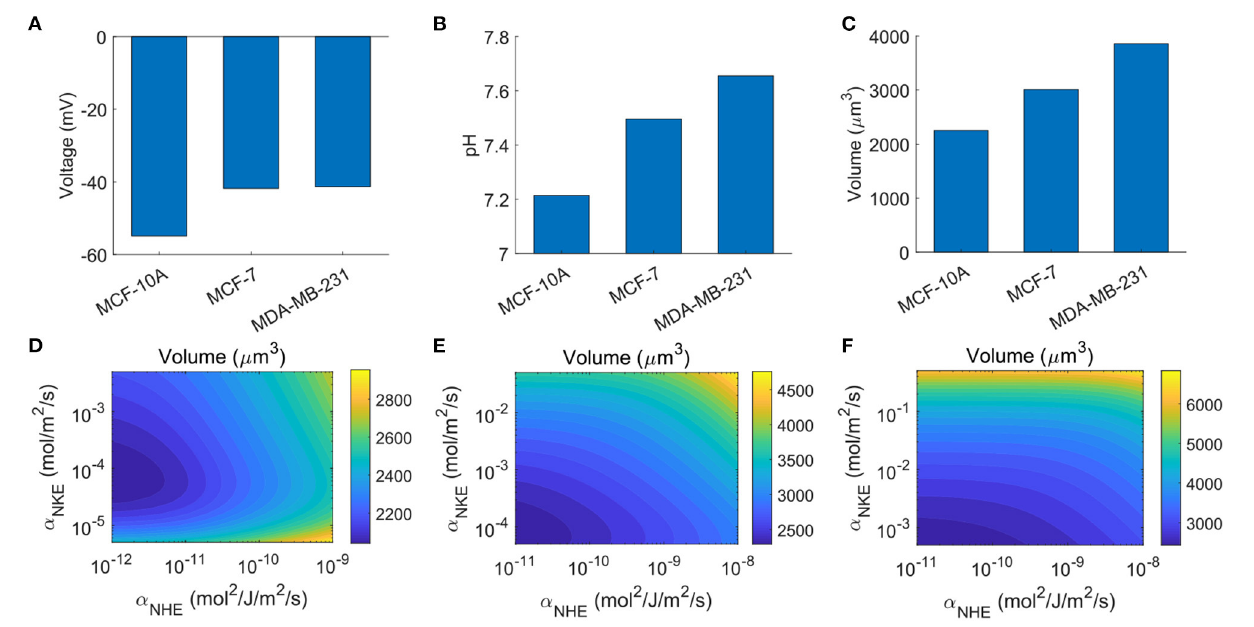
FIGURE 8 | Examples of cell type-dependent cell properties. (A) Computed cell membrane potentials. (B) Model prediction on the intracellular pHs. (C) Model prediction on the cell volume of the three cell types, assuming the cell protein contents are identical. (D–F) The contour of cell volumes for MCF-10A, MCF-7, and MDA-MB-23, respectively, as functions of NKE and NHE activities. The variation of NKE and NHE activities ranges from 10 − 2 to 10 folds based on the values listed in Table 2